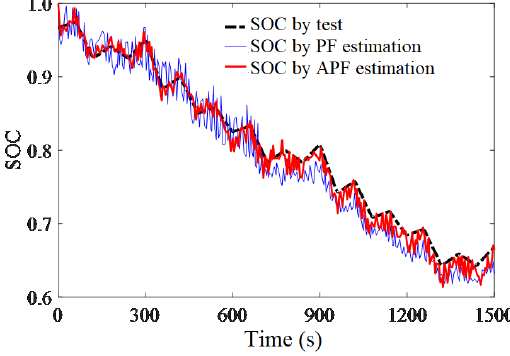
Figure 12. Comparison of SOC between PF and APF estimation.